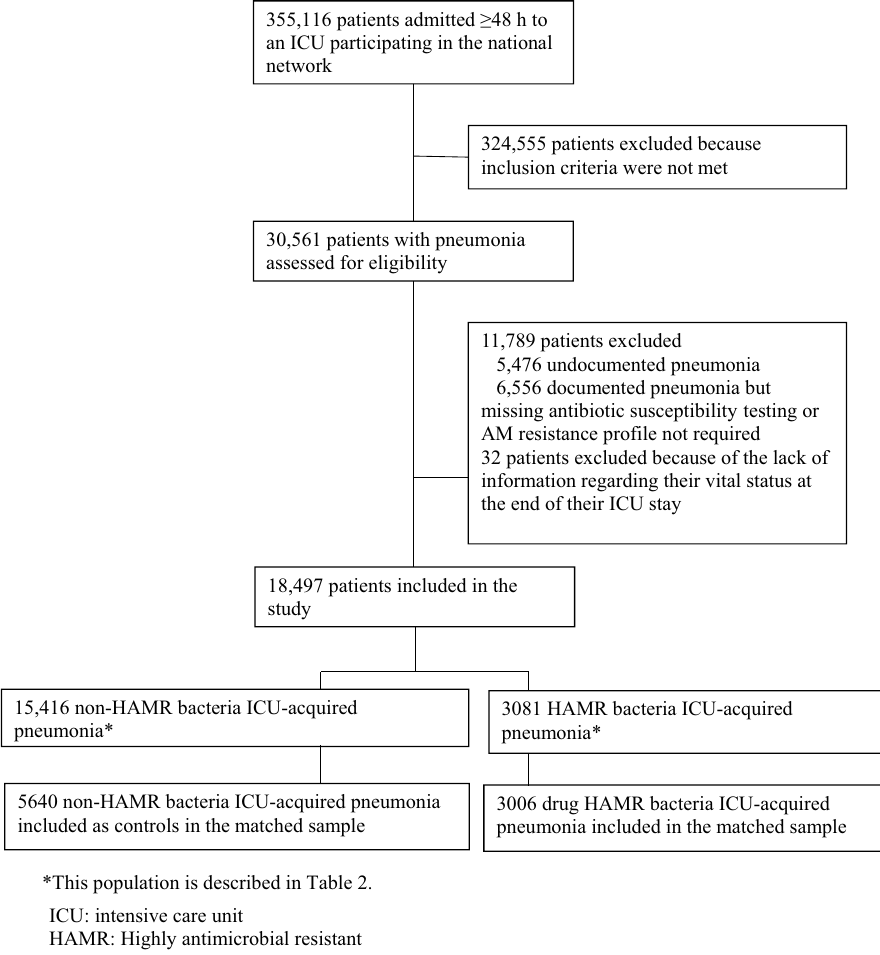
Figure 1. Selection of the final study group (n = 18,772) from 355,116 patients hospitalized ≥ 48 h in French ICUs,